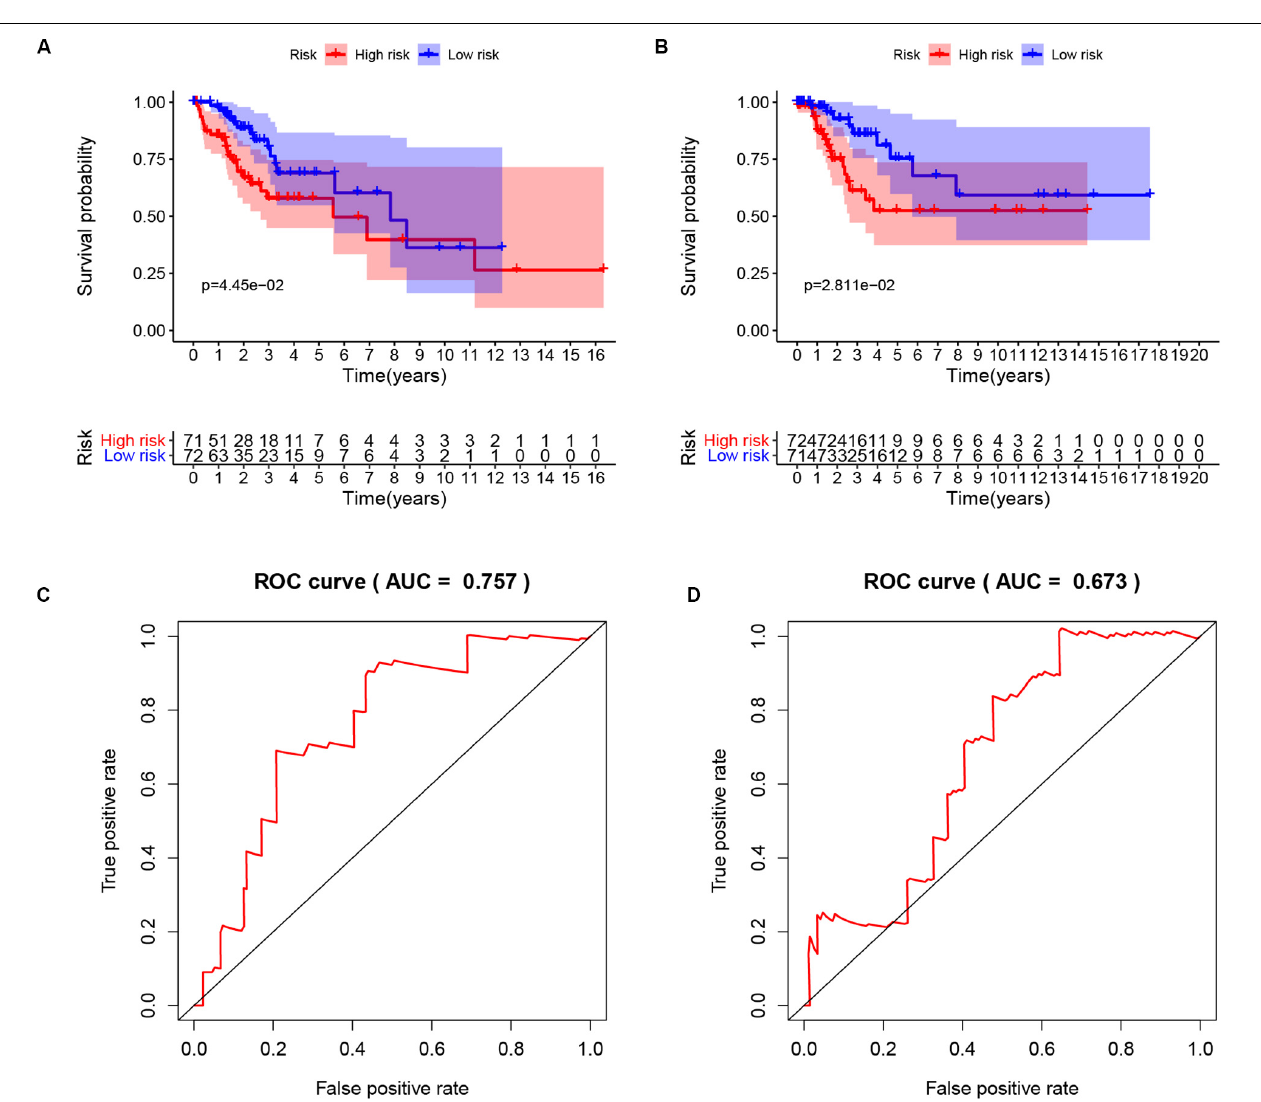
FIGURE 8 | Validation of the TMBPM in the testing set I and testing set II. (A) Kaplan-Meier curves of OS of low- and high-risk groups in the testing set I ( p = 0.0445). (B) Kaplan-Meier curves of OS of low- and high-risk groups in the testing set II ( p = 0.0281). (C) ROC curve for judging the accuracy of the TMBPM in the testing set I (AUC = 0.757). (D) ROC curve for judging the accuracy of the TMBPM in in the testing set II (AUC = 0.673). TMBPM, TMB Prognostic model; OS, overall survival; ROC, Receiver operating